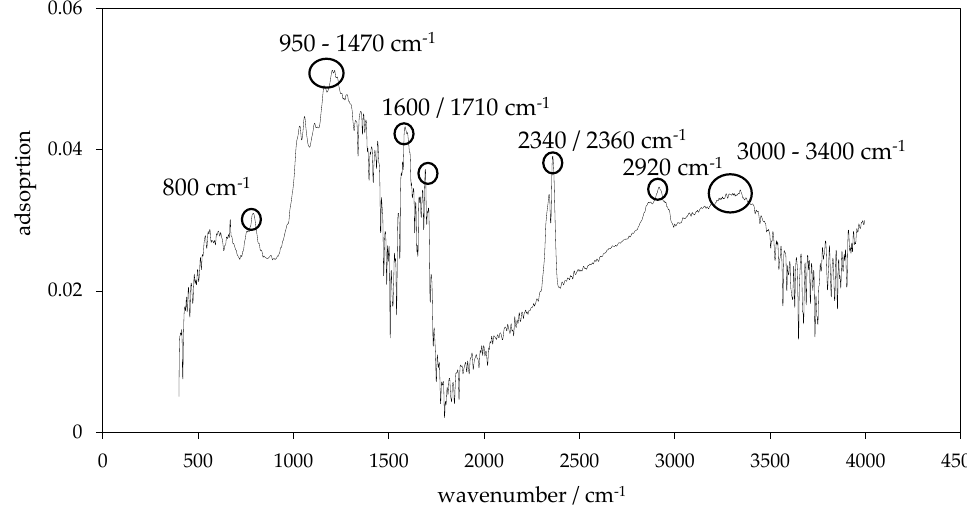
Figure 9. Fourier transform infrared spectroscopy (FTIR) spectrum of hydrochar HTC-220-5.